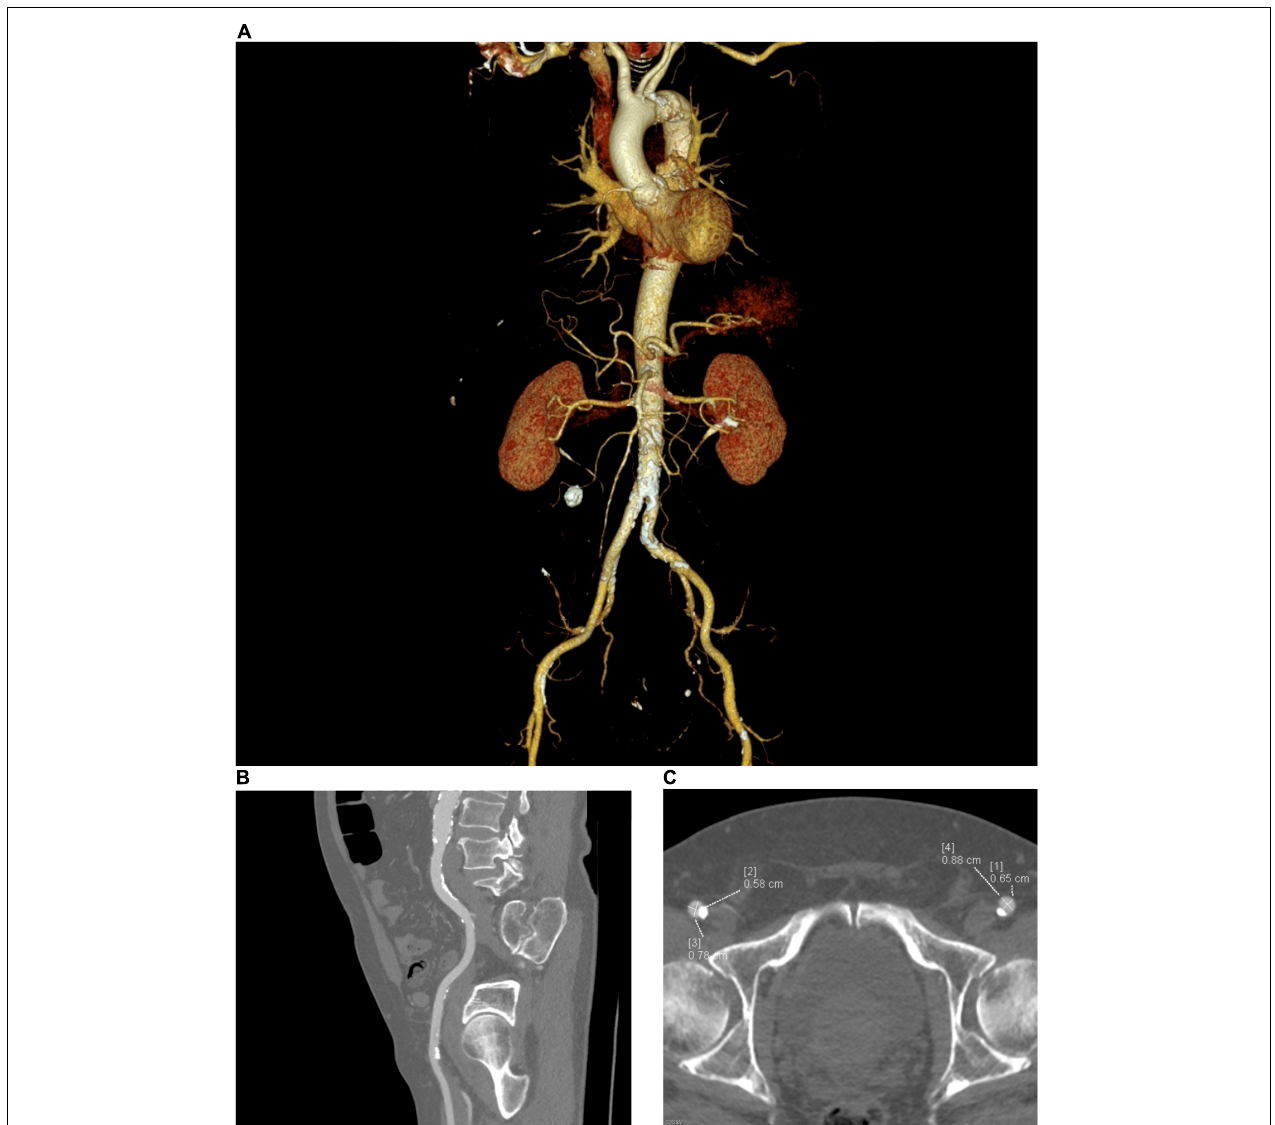
FIGURE 1 | Peripheral access planning for TAVR, requires assessment of the size, tortuosity, calcification (both severity and distribution) and any prosthetic material such as stents or pathologies such as aneurysms. (A) Multiplanar reconstruction of the vascular tree, (B) Sagittal view, (C) Axial